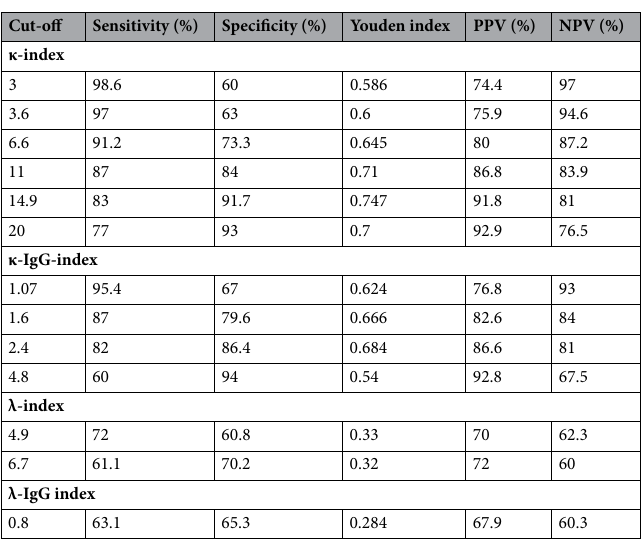
Table 3. Sensitivity, specificity, positive, and negative predictive values of the different studied CSF FLC- related parameters for the diagnosis of multiple sclerosis. PPV positive predictive value, NPV negative predictive